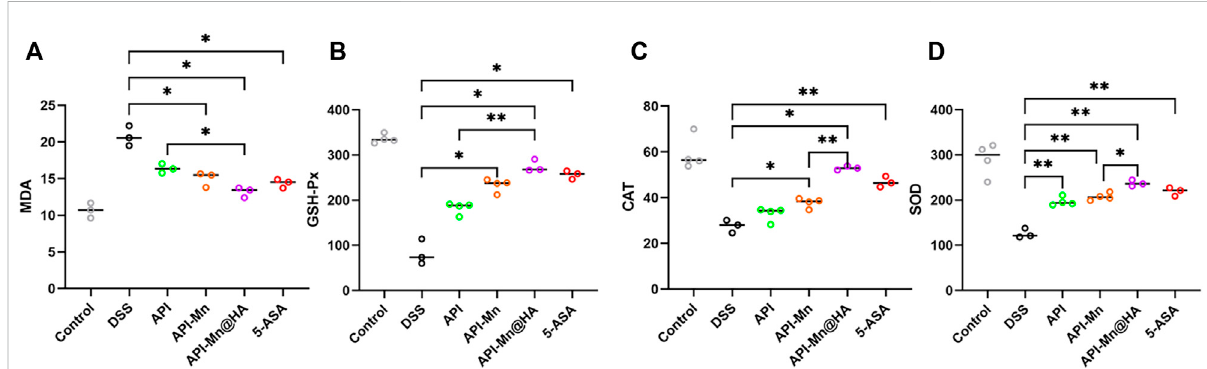
FIGURE 7 EffectsofAPI-Mn(II)complexandAPI-Mn(II)@HAnanoparticlesontheoxidativestressindexinDSS-inducedmice. (A) TheMDAactivityofcolon tissue of mice in DSS group is much higher than other groups, showing more severe in fl ammatory response. (B) The SOD activity of colon tissue of mice. (C) The CAT activity of colon tissue of mice. (D). The GSH-Px activity of colon tissue of mice. Data are shown as mean ± SD. n = 5, * p <